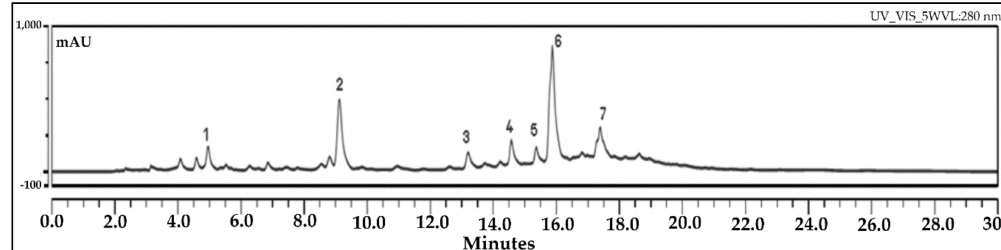
Figure 2. The ultra-high-performance liquid chromatography (UHPLC) chromatogram of the aqueous extract of C. siliqua (CsAE) indicating the picks following: 1. Gallic acid; 2. Epicatechin; 3. Chlorogenic acid; 4. Ca ff eic acid; 5. Quercetin-3-glucoside; 6. Luteolin-7-glucoside; 7.